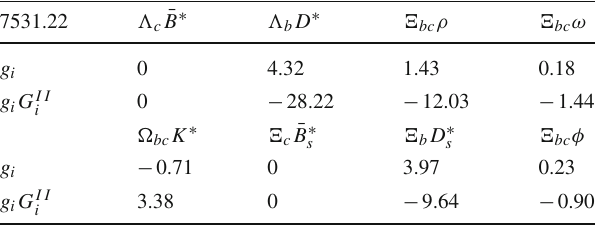
Table 26 Coupling constants to various channels and g i G II with q